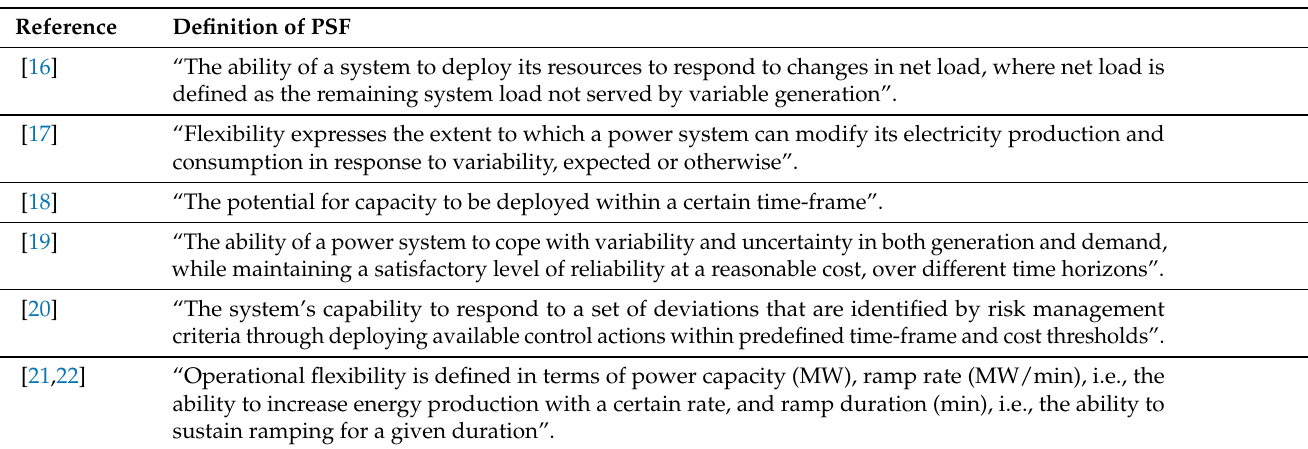
Table 1. Definitions of PSF contributed by authors and